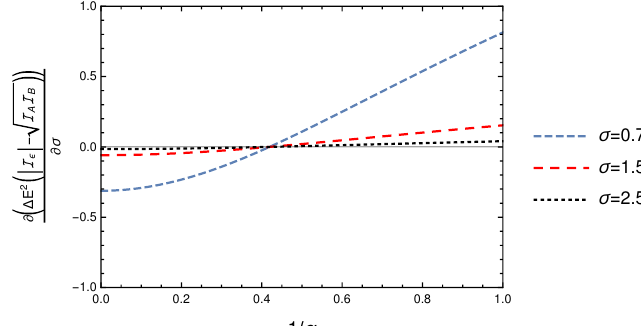
Figure 17 . In (1 + 3) dimensions the quantity ( ∂/∂σ ) anti-parallelly accelerating detectors with respect to the inverse temperature of the thermal bath σ for equal magnitude of proper accelerations α